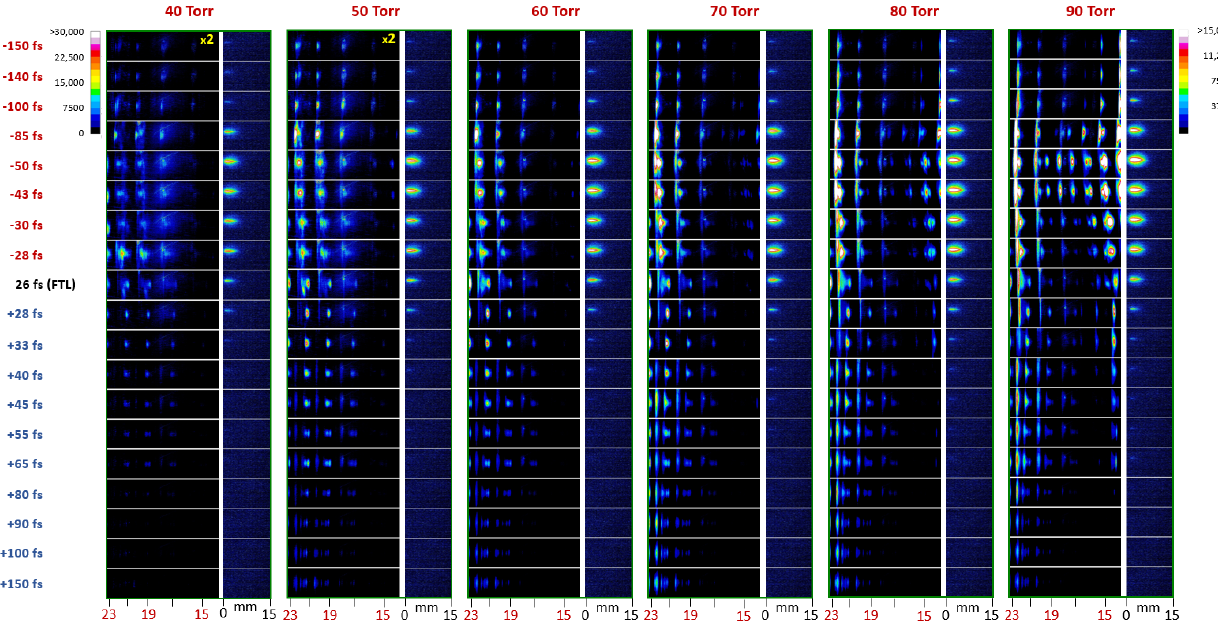
Figure 2. XUV harmonic spectral images ( left ) and corresponding plasma formation images ( right ) measured for various laser pulse durations and Ar gas pressures in the semi-infinite cell. The focus of the laser beam is at the exit pinhole of the semi-infinite cell. The negative/positive signs of the laser pulse durations correspond to the imposed negative/positive chirp, respectively. The nominal spectral locations of the harmonics order, estimated according to the optical geometry of the experimental setup, are noted at the bottom of the XUV spectral images for each gas pressure. The colour intensity of the XUV spectral images corresponding to the pressures of 40 and 50 Torr was multiplied by a factor of two, as indicated at the top of the images, for better visibility.